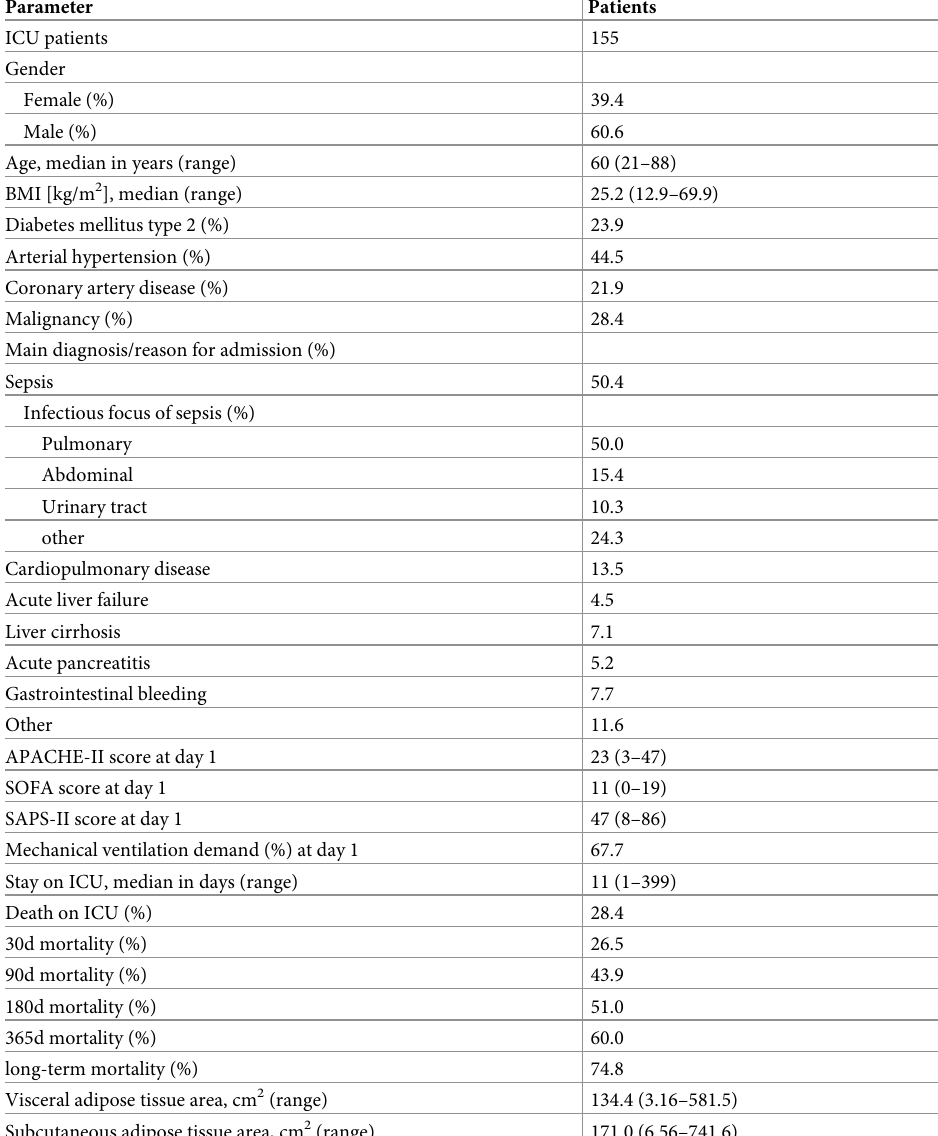
Table 1. Baseline patient characteristics at the time point of admission and mean visceral and subcutaneous adi- pose tissue areas.